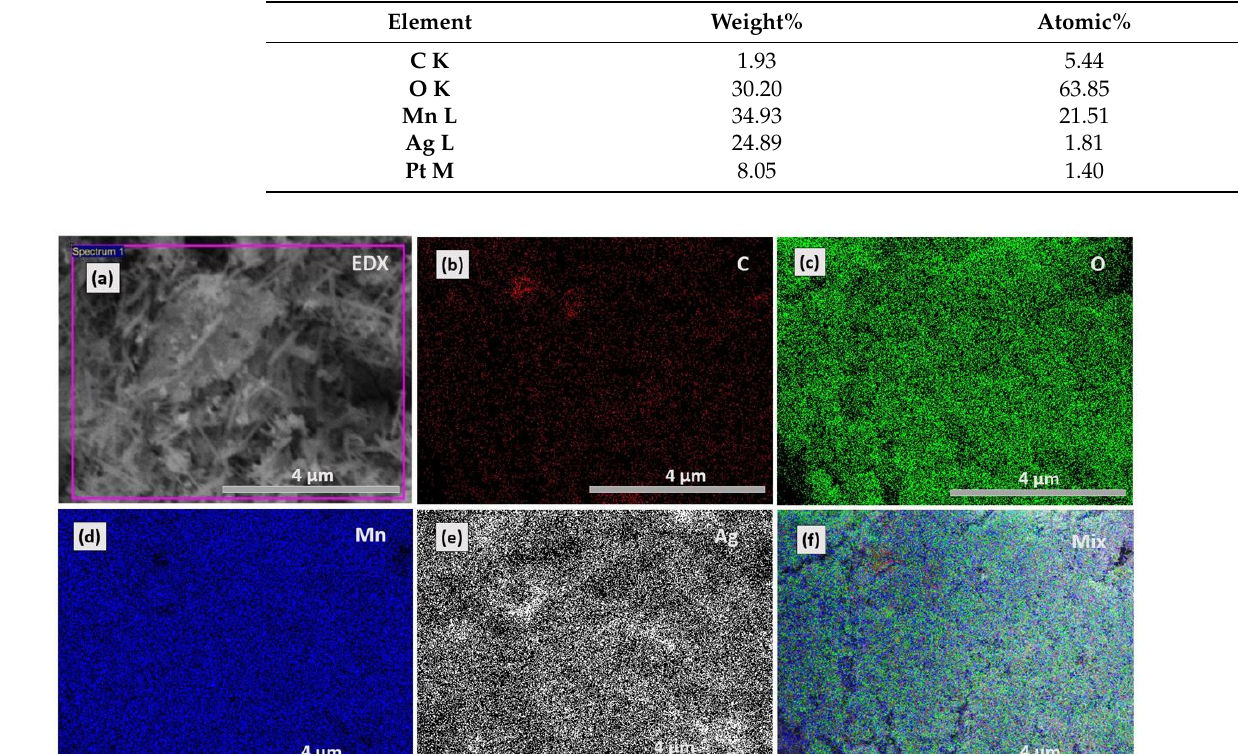
Figure 4. EDX spectrum of ( a ) pure MnO 2 , ( b ) rGO@MnO 2, and ( c ) Ag-rGO@MnO 2 nanocomposite. Table 1. EDX analysis showing the elemental composition of Ag-rGO@MnO 2 nanocomposite.